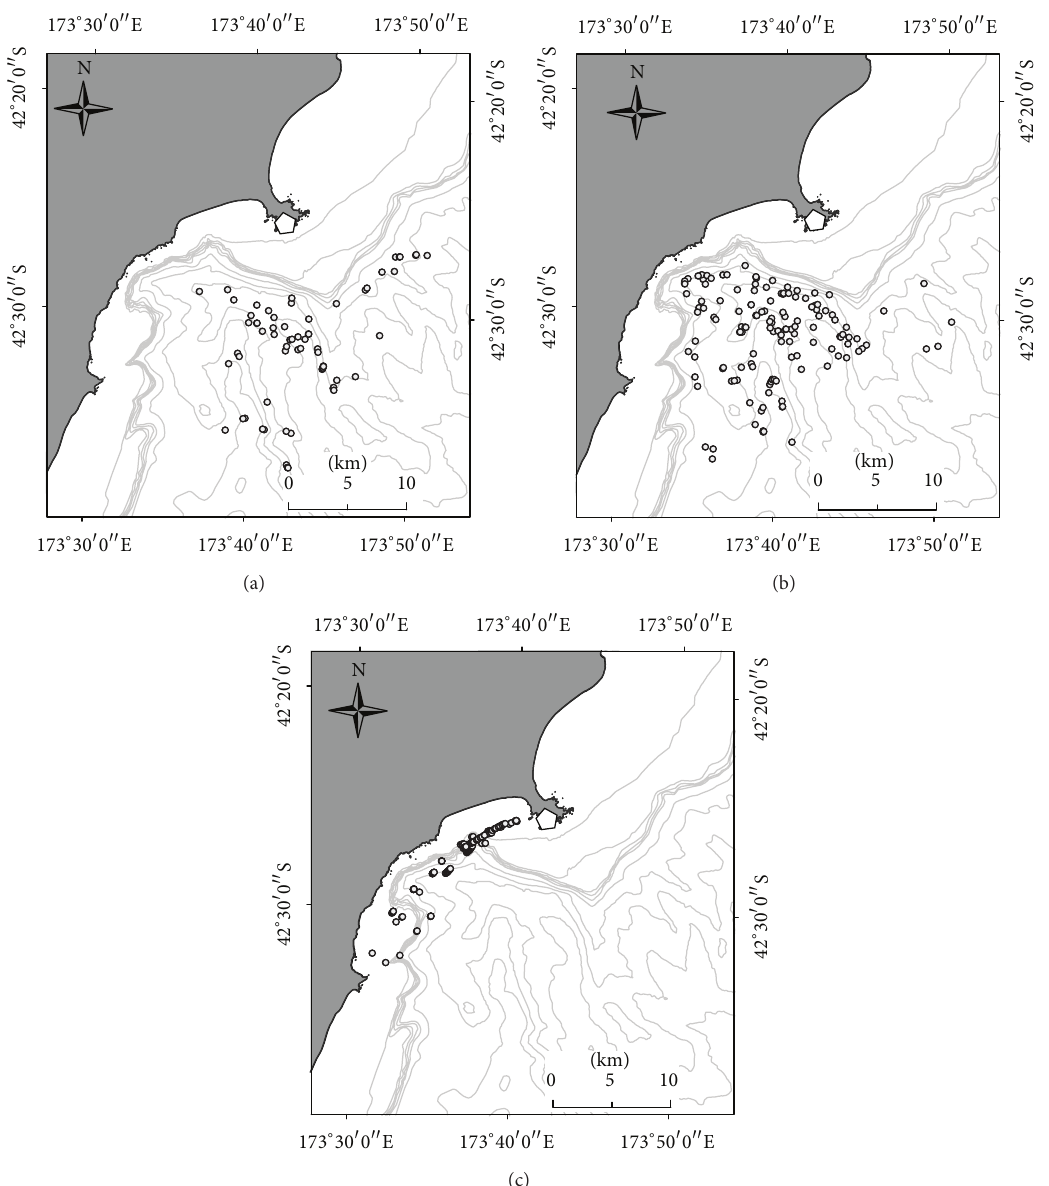
Figure 2: Research vessels locations recorded by onboard GPS by year. (a) and (b) are fixes from the sperm whale research vessel (2010 and 2011) and (c) is fixes from the dolphin research vessel (2012) (pentagon: shore-based station, grey dot: research vessel